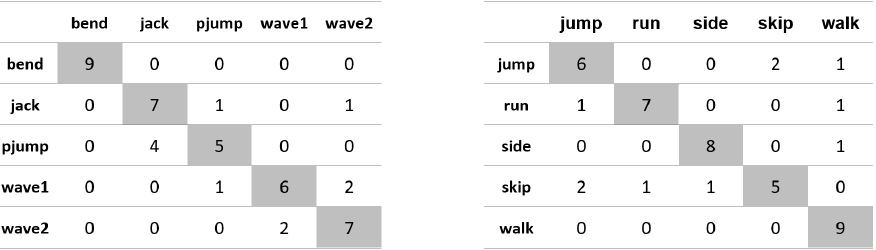
Figure A33. Confusion matrices for the experiment using the ‘upper-occlusion’ database, MBR area and C1 correlation.